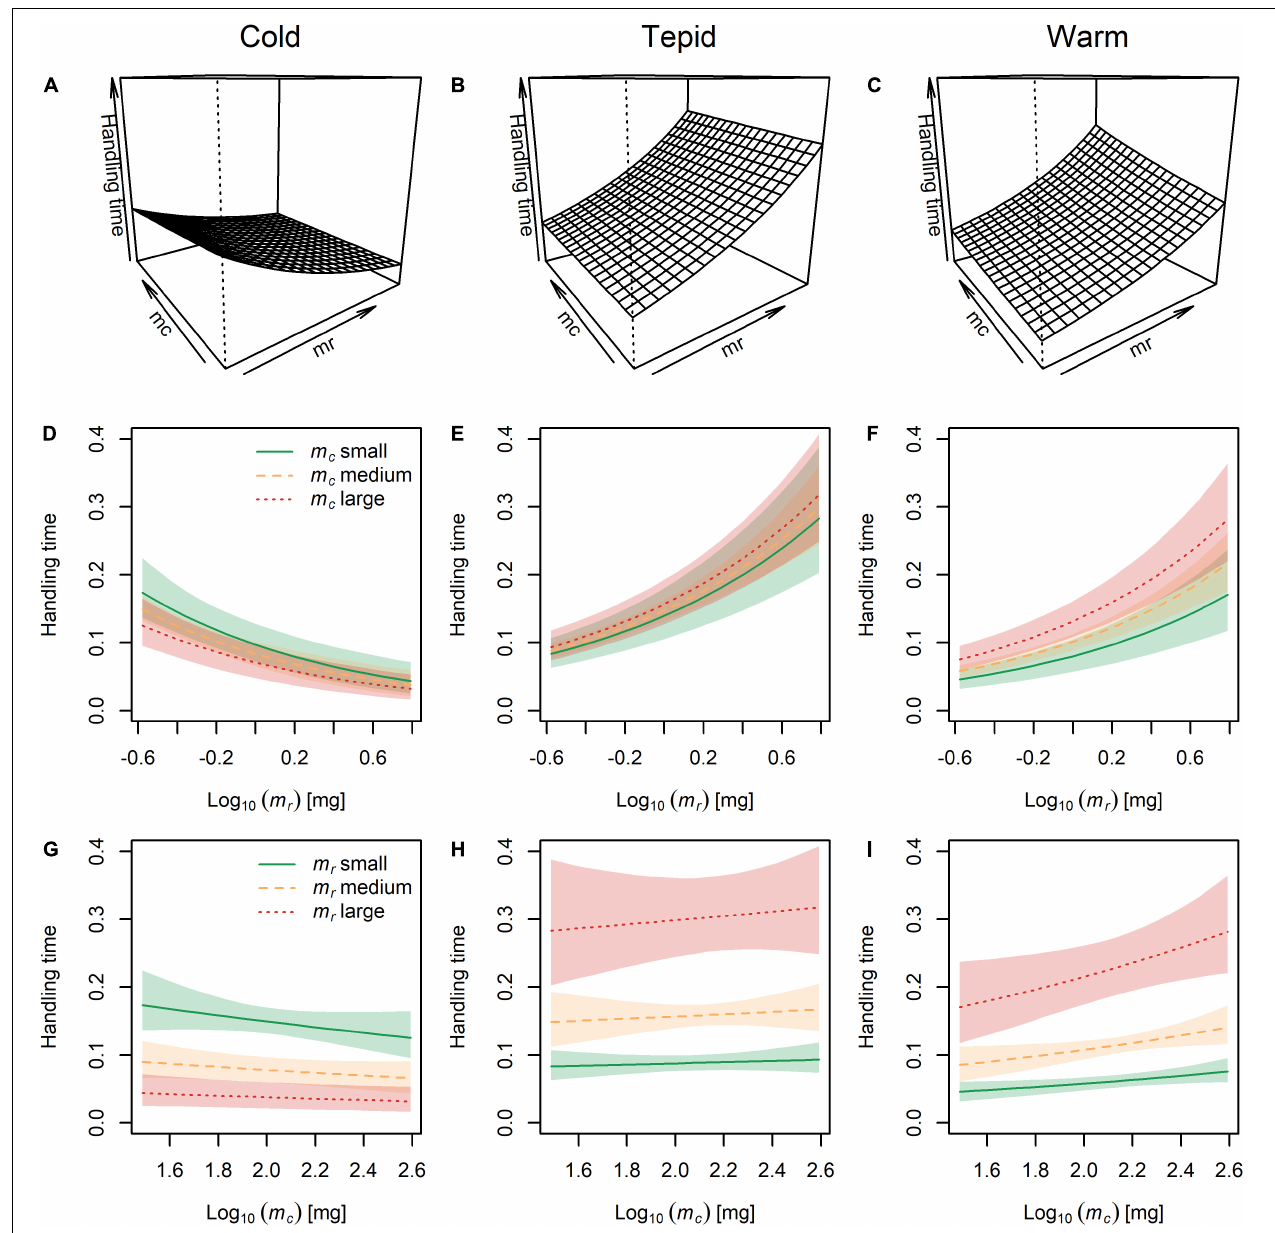
FIGURE 4 | The combined effects of temperature and body mass of the predator ( m c ) and prey ( m r ) on handling time. (A–C) Three-dimensional visualization of handling times across the full range of predator and prey body masses at each experimental temperature. (D–F) Handling times for small, medium, and large predators across the full range of prey body masses at each temperature. (G–I) Handling times for small, medium, and large prey across the full range of predator body masses at each temperature. Lines represent the model fit and shaded areas are the Bayesian 95% posterior probability